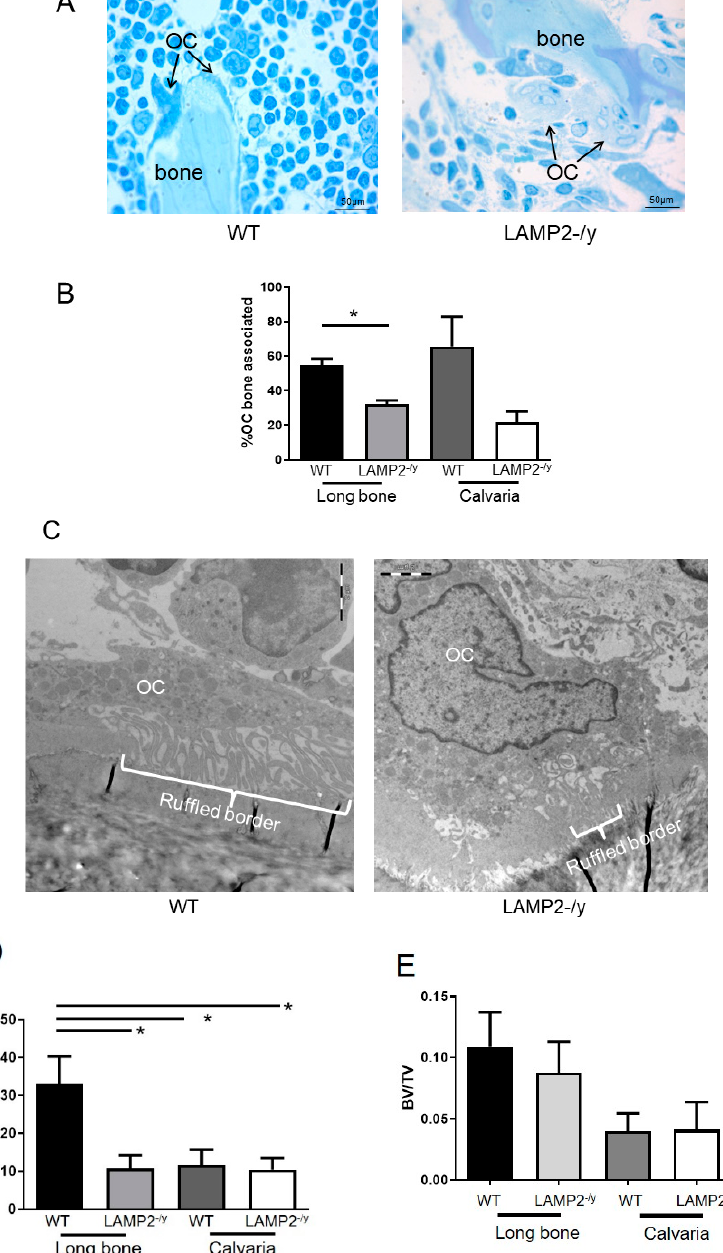
Figure 2. Osteoclast number and bone volume is normal in LAMP-2- / y mice. ( A ) Osteoclasts were normally present in calvariae and long bones of LAMP-2- / y mice. ( B ) Bone associated osteoclasts per total number of osteoclasts present in the light microscopic LM sections. Less bone associated osteoclasts were found in the long bone sections of LAMP-2- / y mice. ( C ) Representative electron micrographs of wild-type (WT) and LAMP-2- / y osteoclasts. In LAMP-2- / y osteoclasts the ruffled border is smaller (indicated with an accolade). ( D ) Length of the ruffled border (RB) per total bone associated cytoplasm, measured in bone associated osteoclasts (OC) ( > 10 sections). Long bone sections show a significant smaller ruffled border in the LAMP-2- / y mice compared to the WT. The calvaria sections also show a smaller ruffled border compared to the long bone sections, but no difference can be found between the calvaria WT and LAMP-2- / y ones. ( E ) µ CT analysis showed that the bone volume / total volume (BV / TV) of LAMP-2- / y mice is equal to the WT mice of same age and gender ( n = 6 ± SD, not